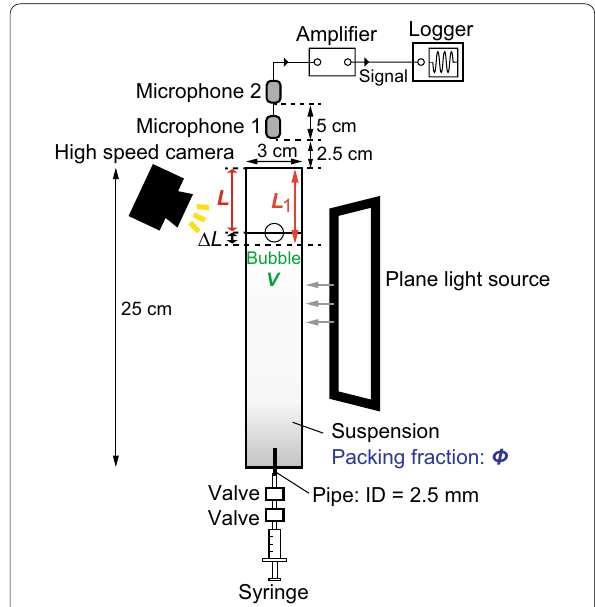
Fig. 2 Schematic diagram of the experimental setup. An acrylic tank is square in the cross section with an inner width W = 2 a = 3 cm and an outer width of 5